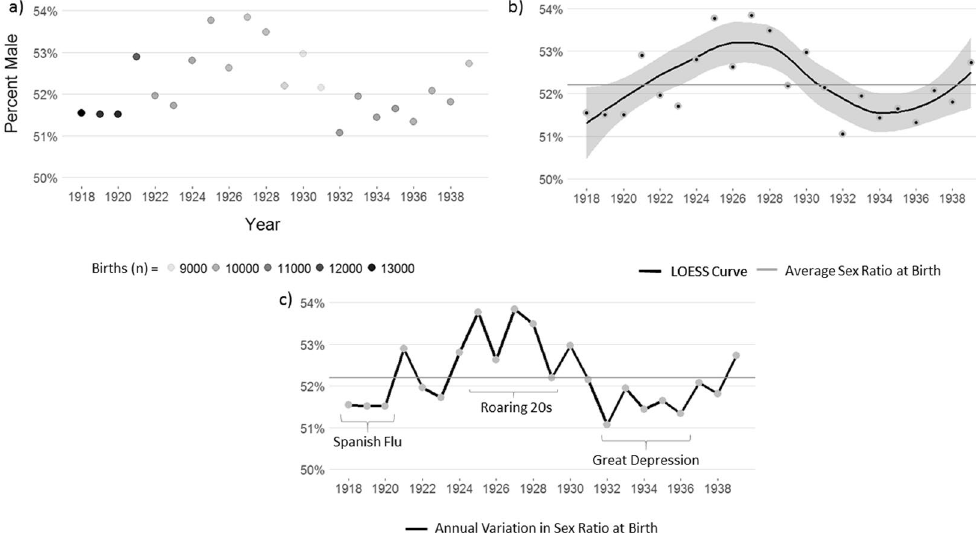
Figure 1. Male percentage of births from 1918–1939 presented in three panels: ( a ) SRB by year plotted with darker circles representing larger birth cohorts. ( b ) LOESS curve fit to the data highlighting nonlinear association over time. ( c ) line graph of interannual variation in SRB with eras